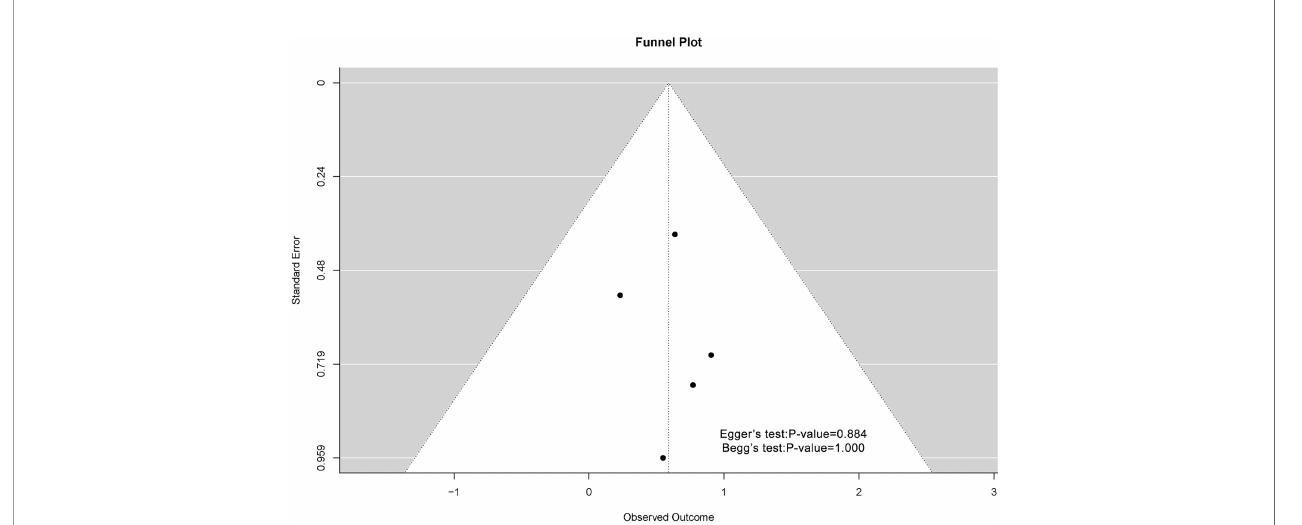
FIGURE 4 | Begg ’ s funnel plots for the publication bias test of OS.